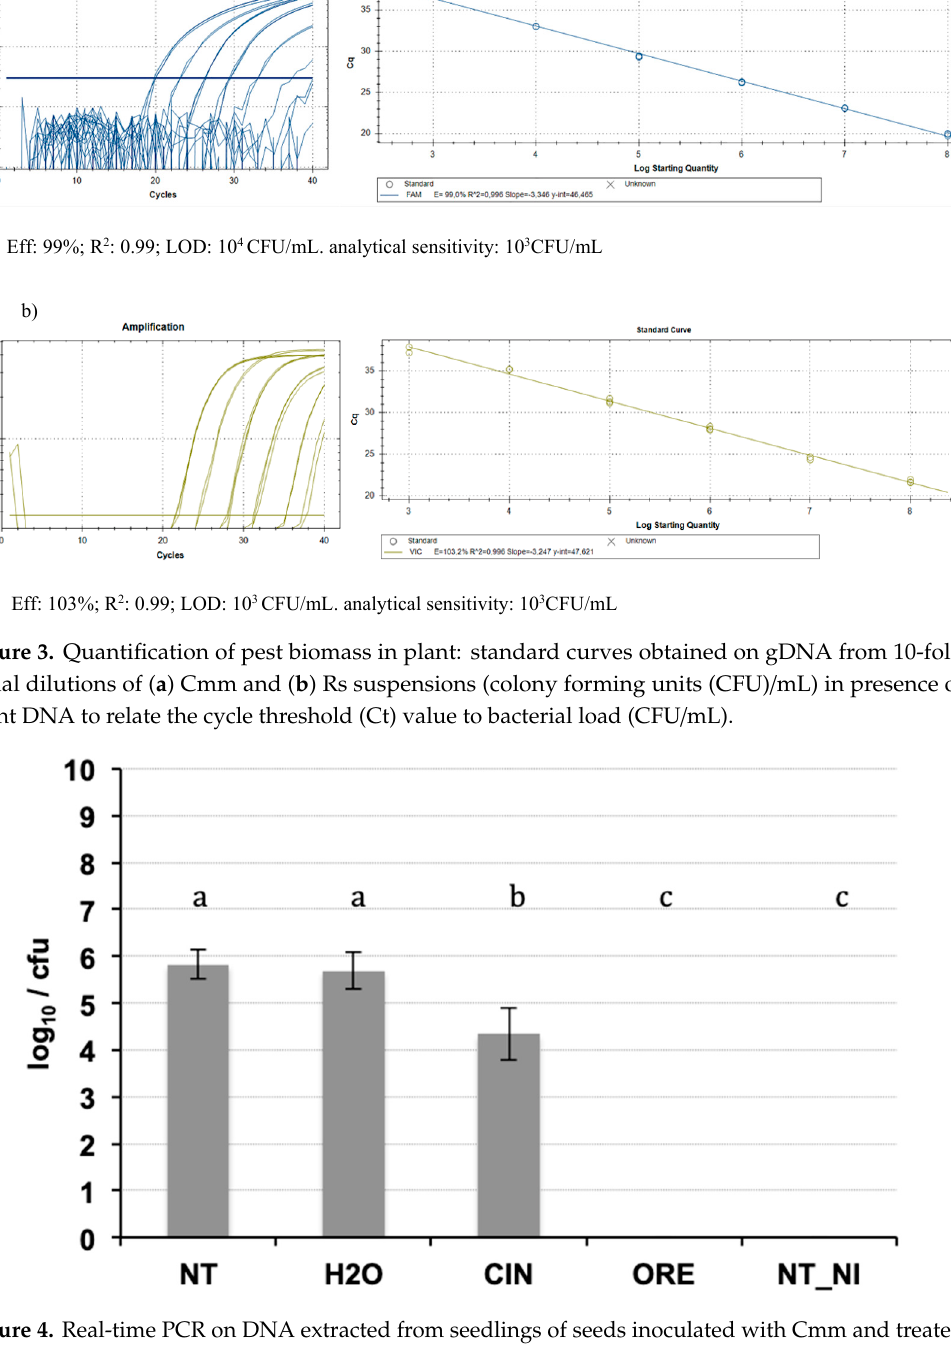
Figure 4. Real-time PCR on DNA extracted from seedlings of seeds inoculated with Cmm and treated or not with essential oils (cinnamom and oregano). Significant differences ( p ≤ 0.01) found using the Student Newman test for multiple comparisons are indicated as letters a–c: the same letter means no statistical difference between the treatments. NT: inoculated not treated; H2O: inoculated and treated with water; CIN; inoculated and treated with cinnamon essential oil; ORE: inoculated and treated with oregano essential oil; NI_NT: not inoculated and not treated.